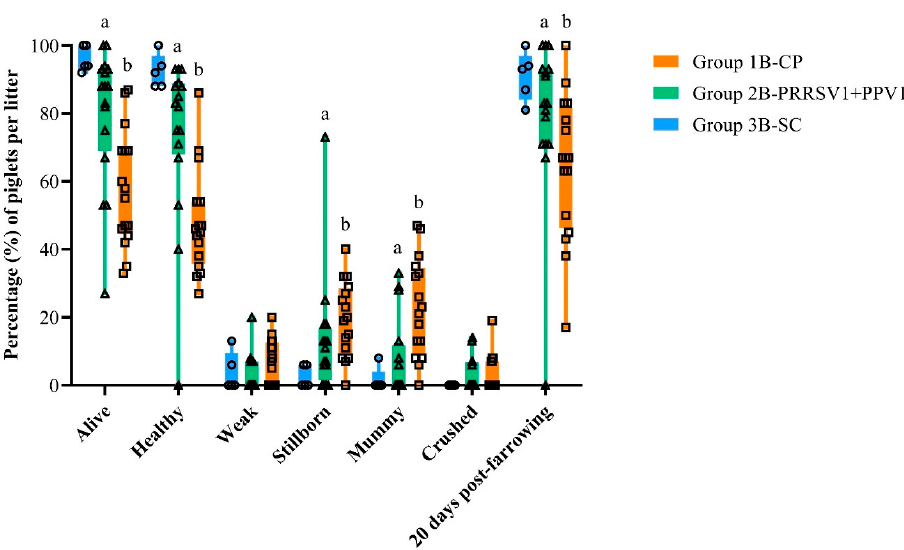
Figure 4. Box plots of proportion (%) of piglets per litter in each reproductive performance category and living piglets at the end of experiment B (20 days post-farrowing). The boxes extend from the 25th to 75th percentiles and the whiskers cover the smallest % value up to the largest. Absolute frequencies per litter of living, healthy, weak, stillborn, mummified, and crushed piglets at farrowing and living piglets at 20 days post-farrowing were determined and evaluated using the Wilcoxon Mann–Whitney test. Group 3B-SC was excluded from statistical analyses. Different letters indicate statistical significance of differences between groups.